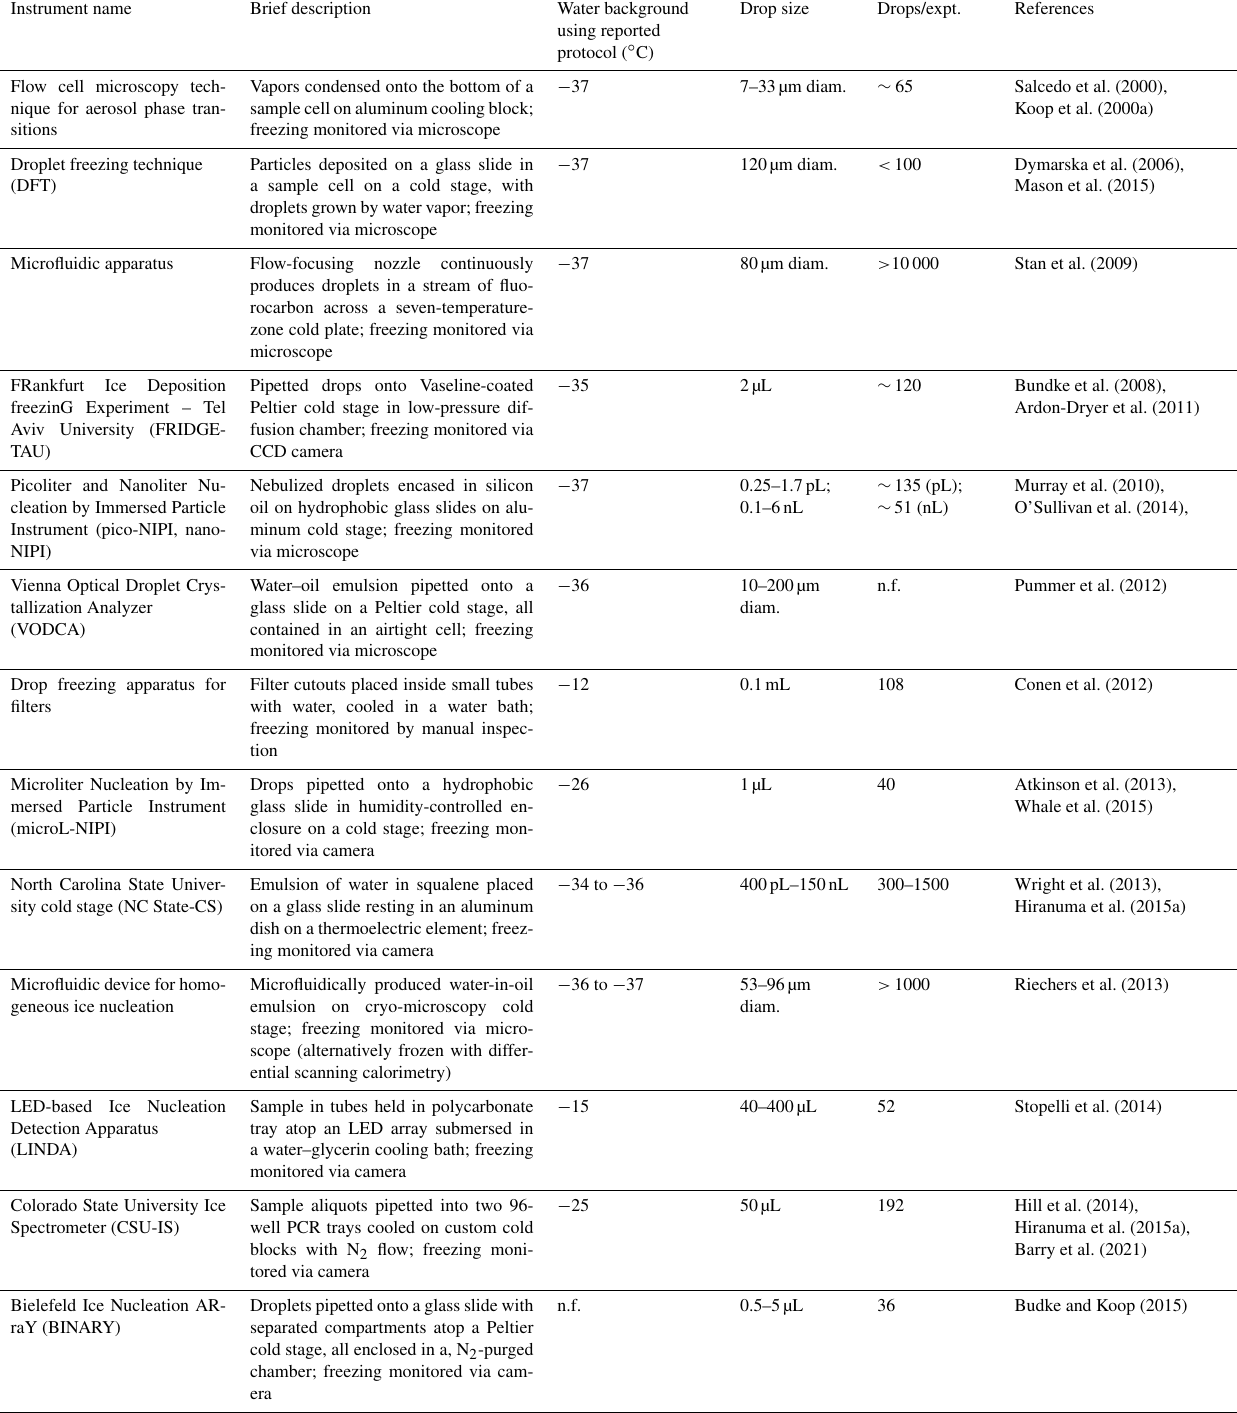
Table 1. List of droplet freezing techniques (DFTs) ordered by year of first publication. Information includes the instrument name, a brief description of the instrument, the freezing temperature of a water background freezing experiment according to the reported protocol (median where available), the droplet size used, the number of droplets per experiment (drops/expt.), and the main references associated with the instrument, including the reference in which the instrument was first published and, if applicable, a following reference with updates; “n.f.” indicates information not